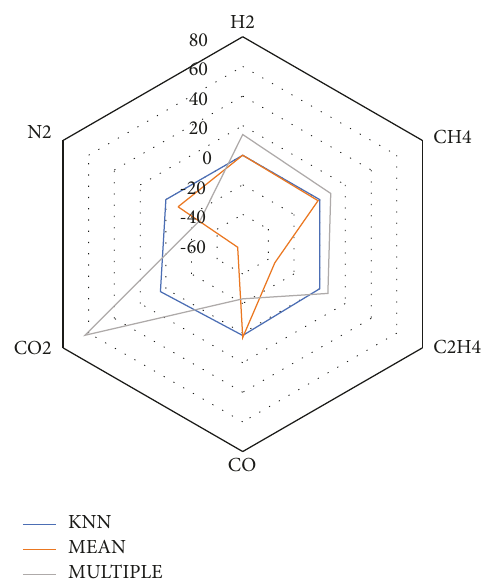
Figure 3: Change in error due to